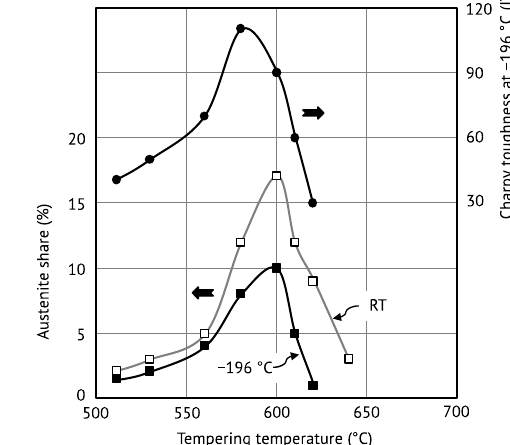
Figure 8. Correlation of Charpy toughness and retained austenite volume fraction at − 196 °C in a cryogenic steel alloyed with 9 wt.% Ni.